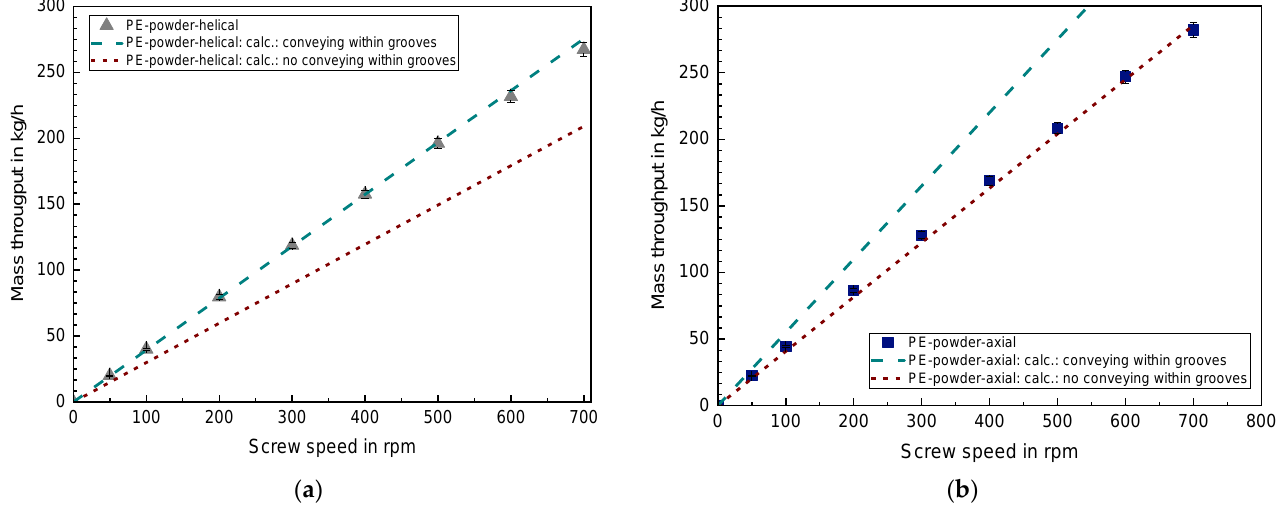
Figure 11. Comparison of the measured throughput for the powdery PE to the calculated throughput ( a ) for the helically grooved and ( b ) for the axially grooved barrel.